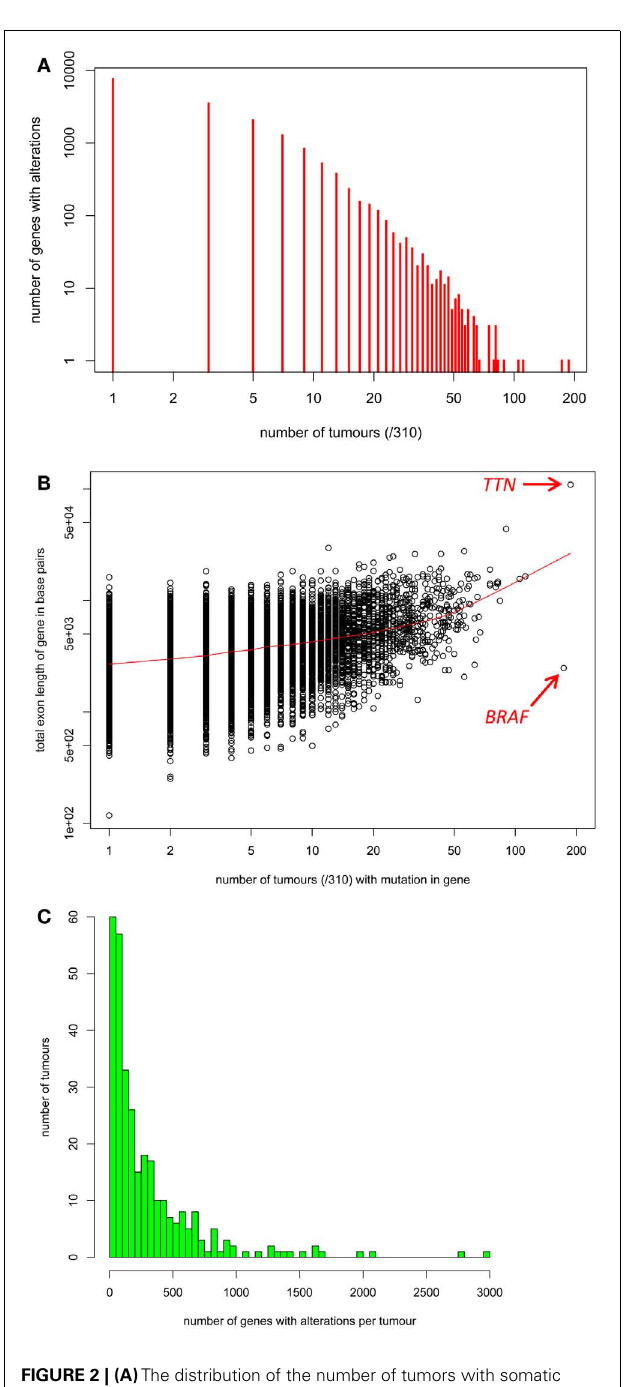
FIGURE 2 | (A) The distribution of the number of tumors with somatic alterations in each individual gene. (B) Each gene’s total exon length in base pairs ( y -axis) versus the number of the 310 tumors with a mutation in that gene ( x -axis). (C) The distribution of the number of genes with somatic alterations in each individual